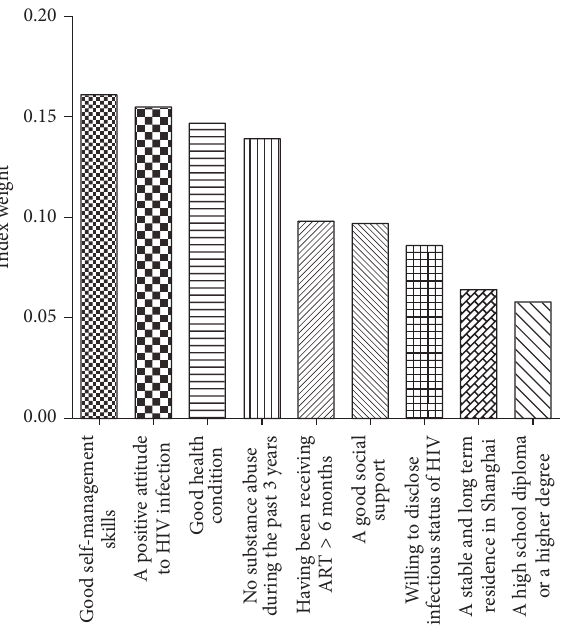
Figure 1: The index weight of each selected indicator.